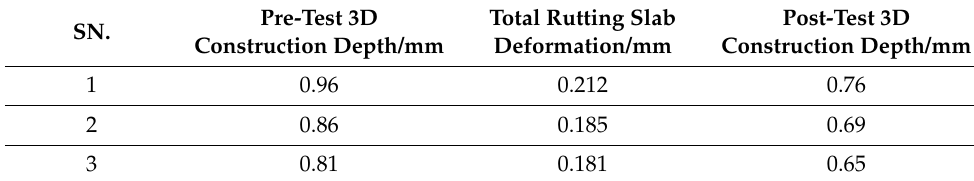
Table 10. Rutting test results.